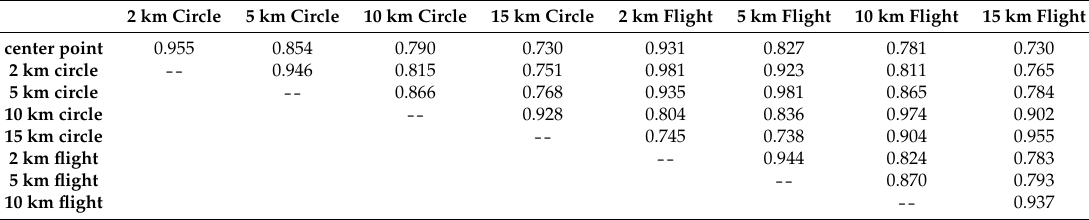
Figure 6. Comparison of measurements of the trajectory divergence rate ˙ ρ at the center point of the circular sampling orbit ( red ), along the path of a simulated UAS flight ( black ), and along a circular arc ( blue ). The radius of the circle and flight path is shown in the lower right hand corner of each subplot. The circular arc and the simulated UAS flight are nearly on top of each other. Table 1. Pearson correlation coefficients for trajectory divergence rate, ˙ ρ , measurements. Coefficients range from 0.730 to